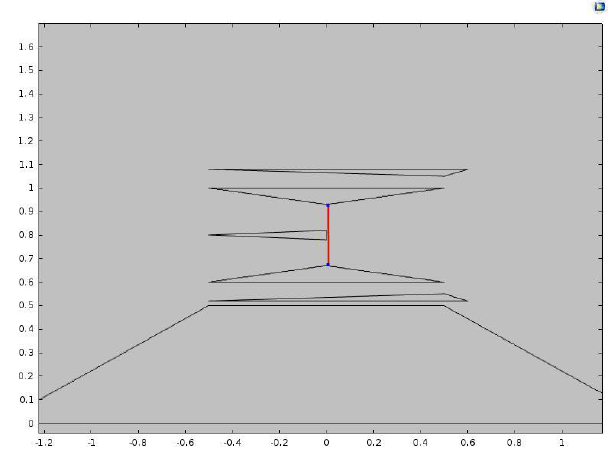
Figure 6. Plot removal area of the airflow